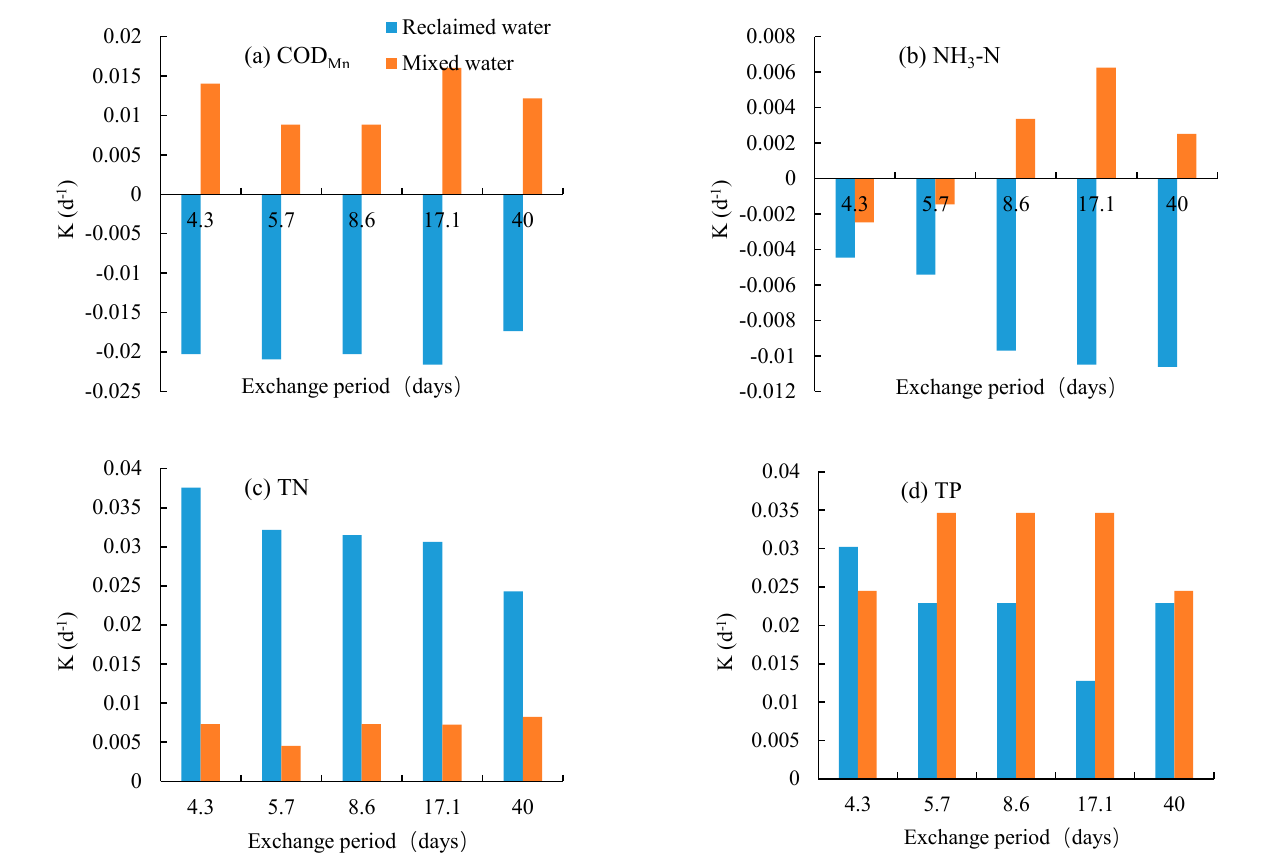
Figure 3. The degradation coefficients ( K ) change in COD Mn , NH 3 –N, TN and TP with water exchange periods. for reclaimed and mixed water. ( a – d ) represent four typical pollutants.